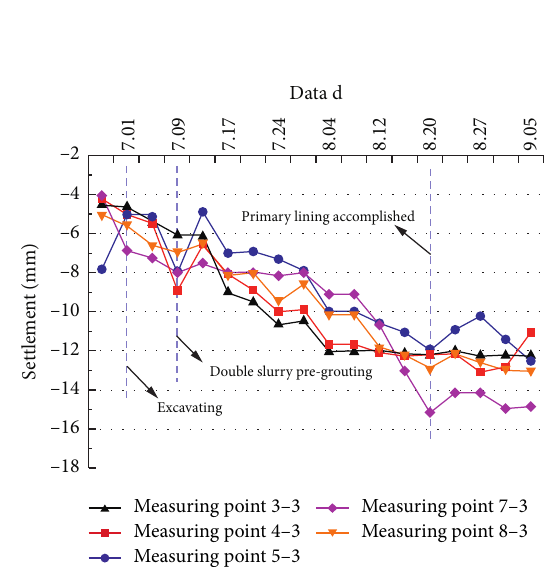
Figure 18: Surface subsidence